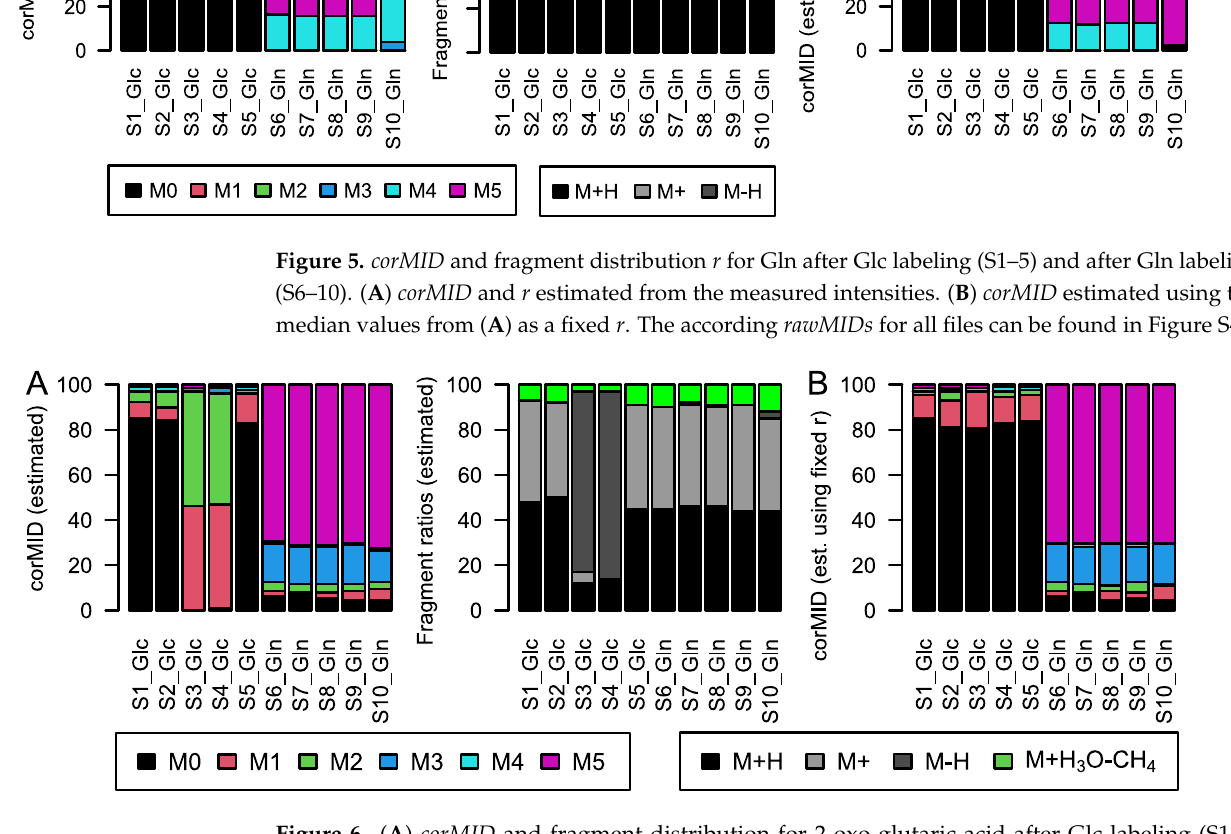
Figure 6. ( A ) corMID and fragment distribution for 2-oxo glutaric acid after Glc labeling (S1–5) and after Gln labeling (S6–10). ( B ) corMID intensities of 2-oxo glutaric acid using a fixed fragment distribution based on the values obtained in ( A ). Note that samples S3 and S4 show different solutions when r and corMID are estimated in parallel while estimating corMID alone ( r fixed) leads to robust results. The according rawMIDs for all files can be found in SI-File1.